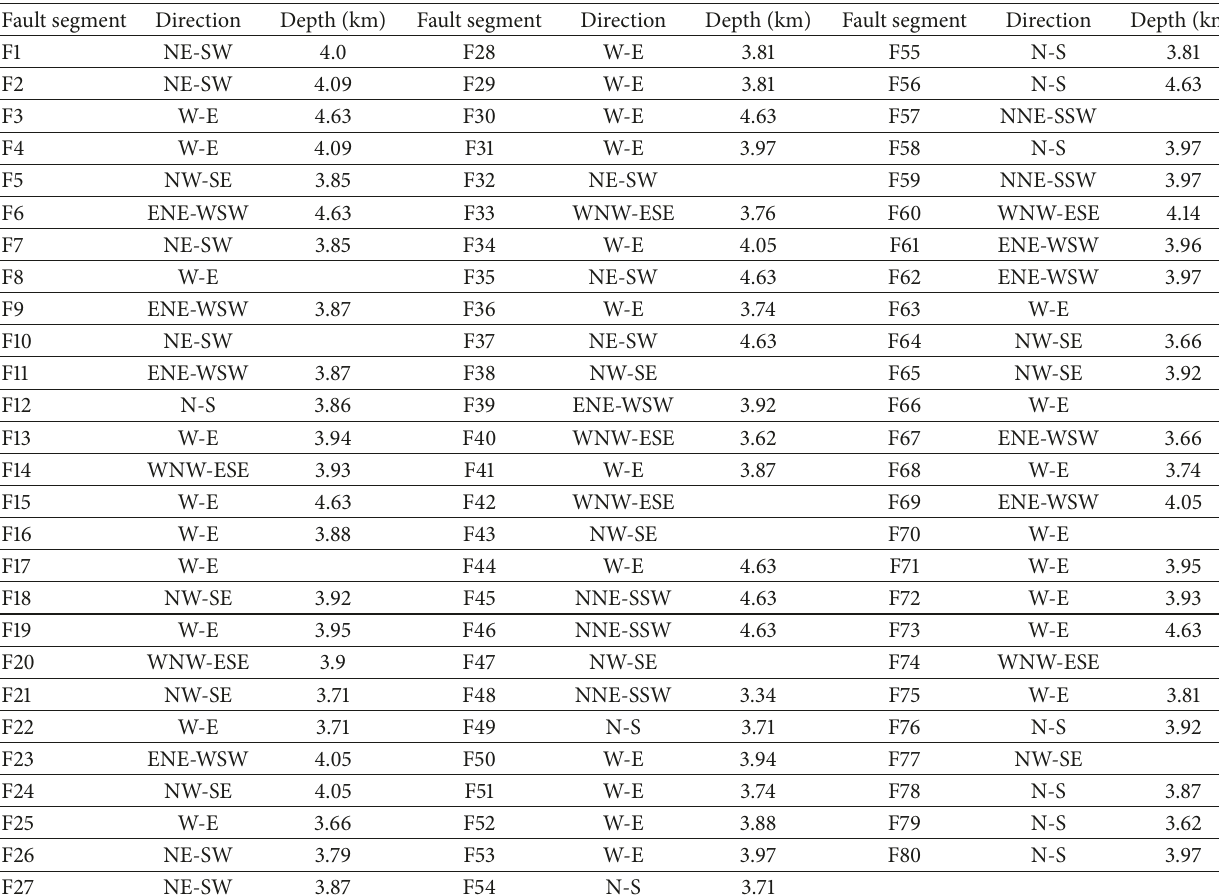
Table 1: Characteristic orientation of different fault